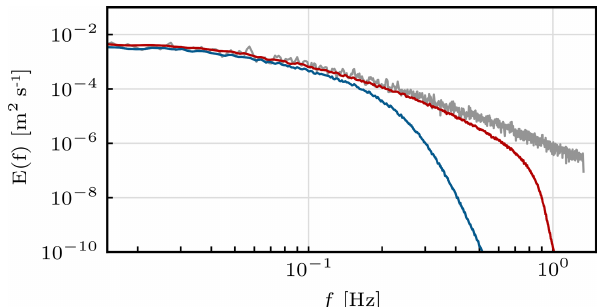
Figure 13. One-point turbulent kinetic energy spectra at the turbine position ( x = 0 D ) without ALM. The spectrum of the synthetic in- let turbulence is given in grey. For the legend, see Fig.